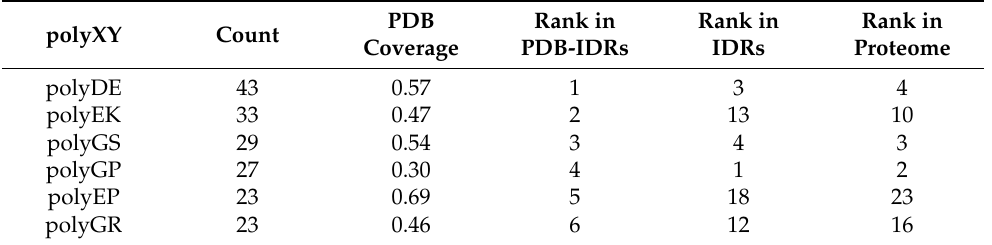
The six most frequent polyXYs in IDRs with homology to PDB. See details in Supplementary Tables S4 and